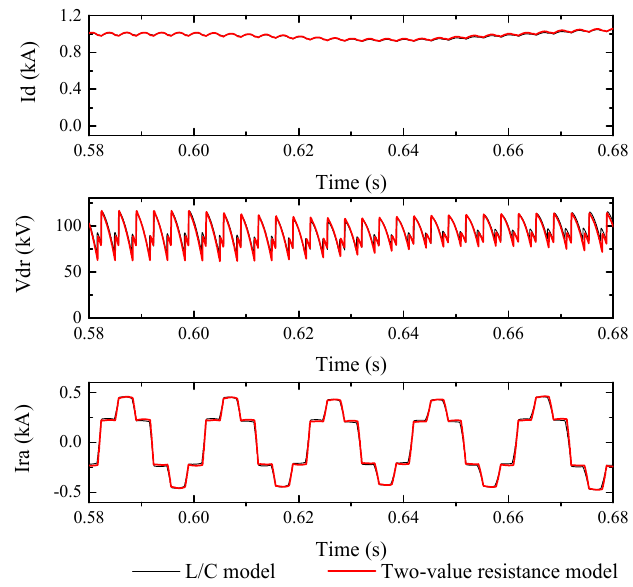
Figure 13. Response of system to a 20% reduction of AC bus voltage at rectifier side. ( Top ) rectifier DC current, ( middle ) rectifier DC voltage, ( bottom ) rectifier AC current (Case 3).